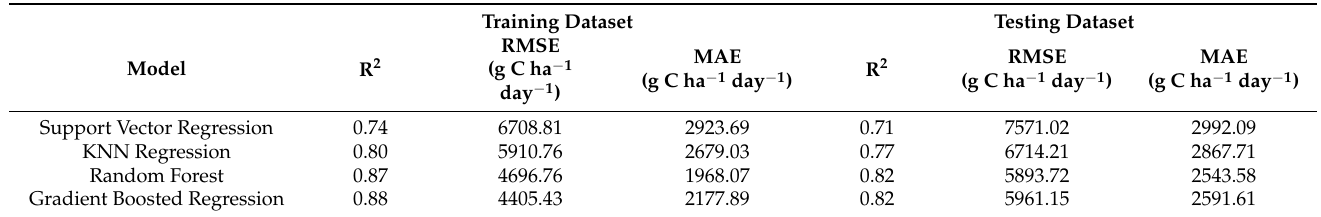
Table 4. Evaluation metrics of machine learning models for predicting CO 2 fluxes in bioenergy